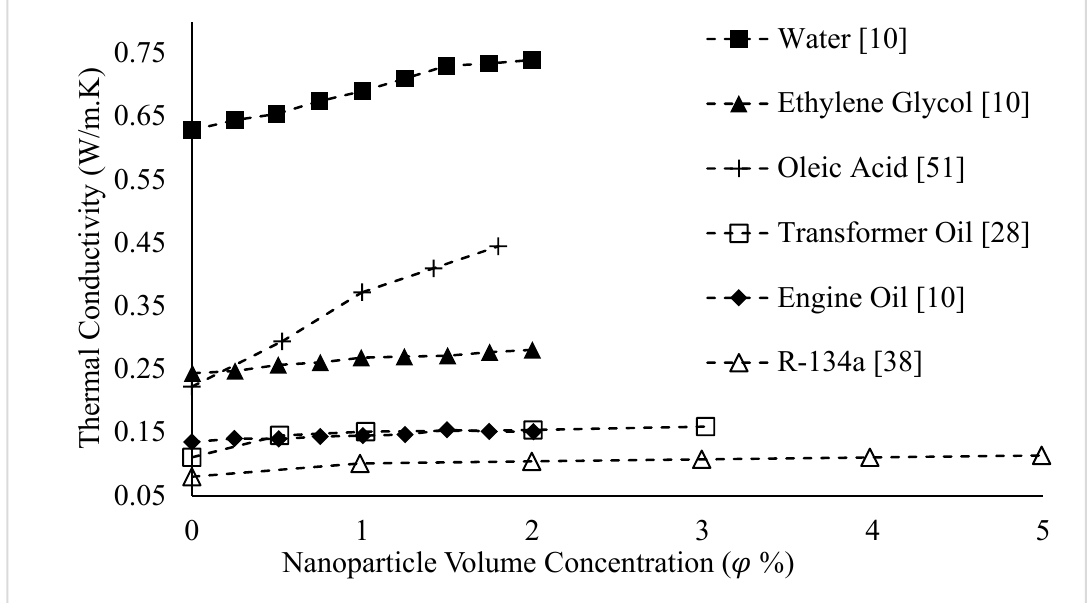
Figure 16. Variation of CuO nanofluid thermal conductivity as a function of nanoparticle volume fraction, 𝜑 , for different base liquids, at room temperature.